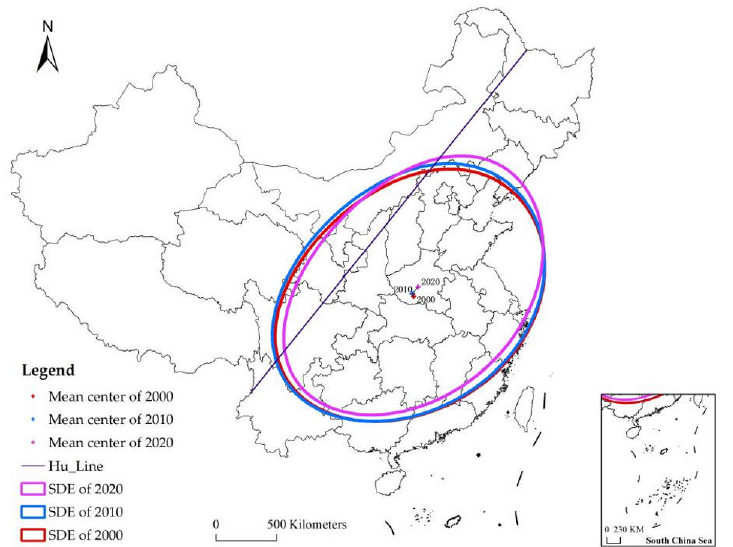
Figure 4. Directional distribution of rural population aging from 2000 to